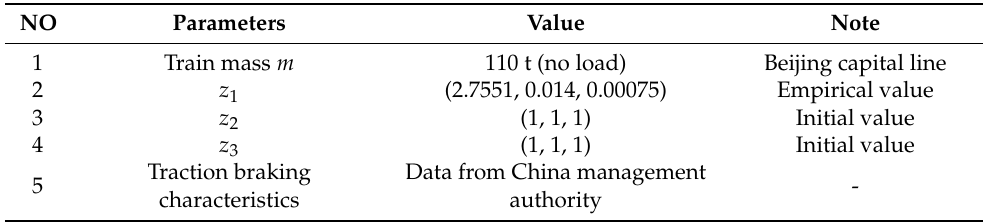
Table 1. System Parameters.